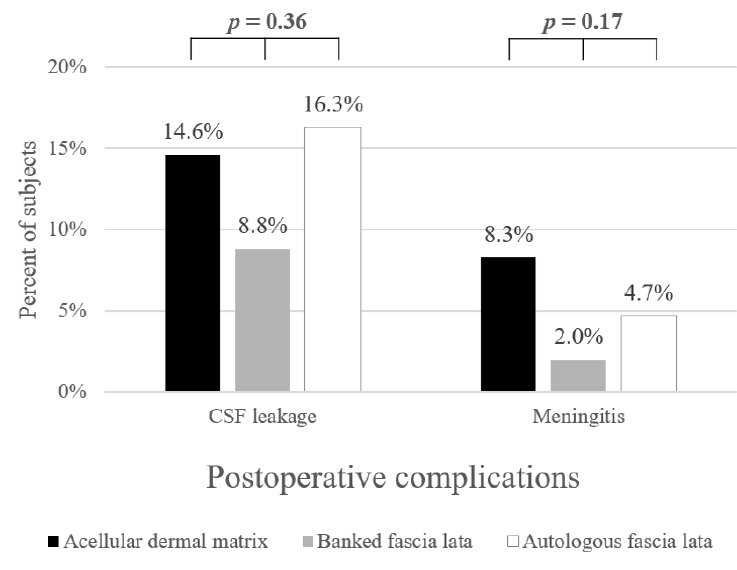
Figure 1. Postoperative complication rate according to graft